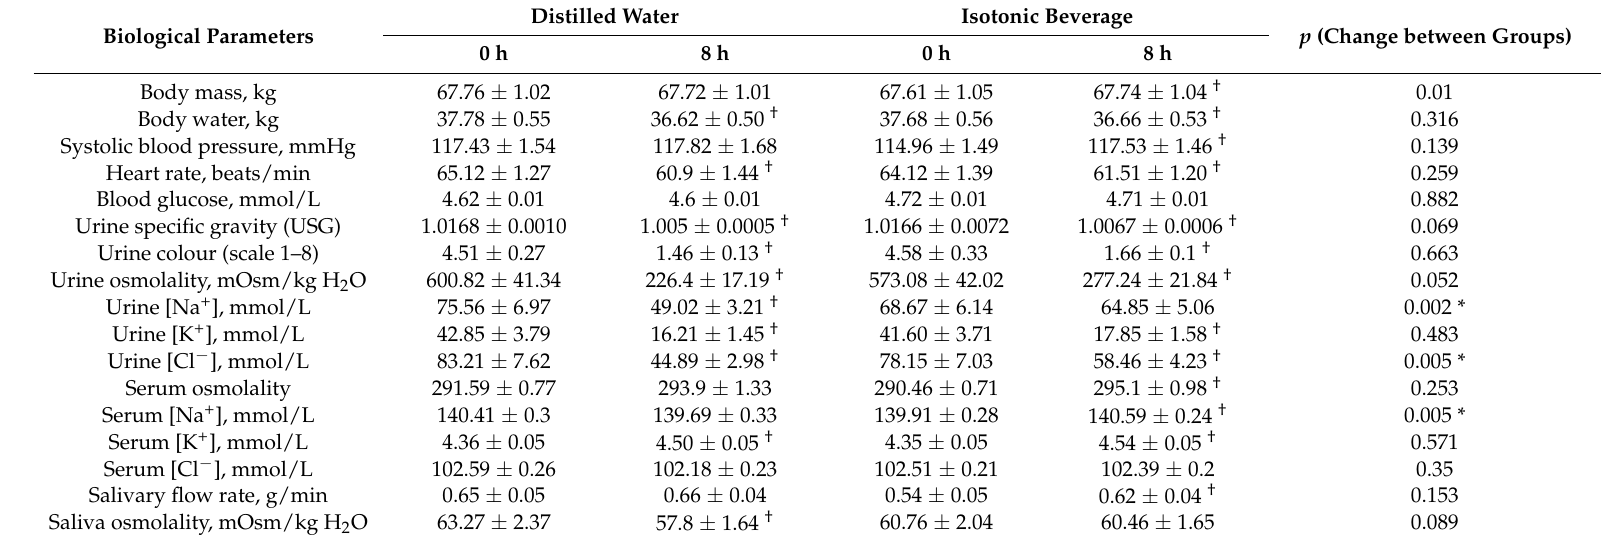
Table 3. Hydration indicators before and after 8 h consumption of distilled water or isotonic